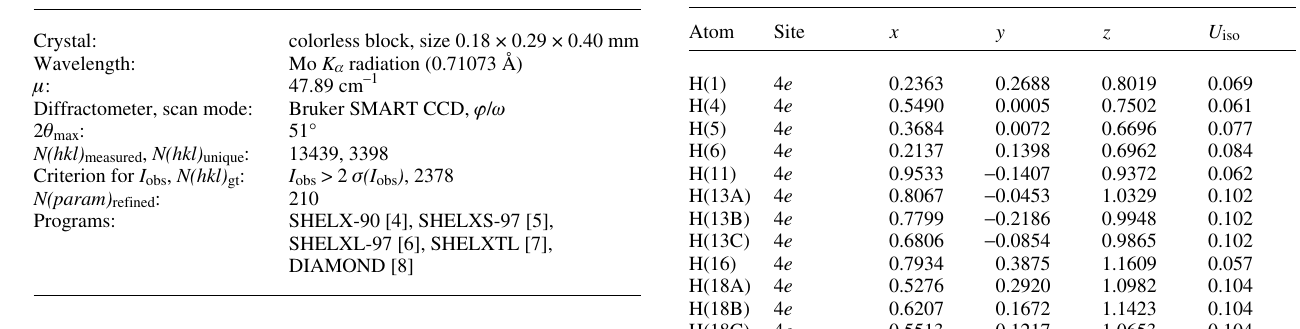
Table 2. Atomic coordinates and displacement parameters (in Å 2 ) . Table 1. Data collection and